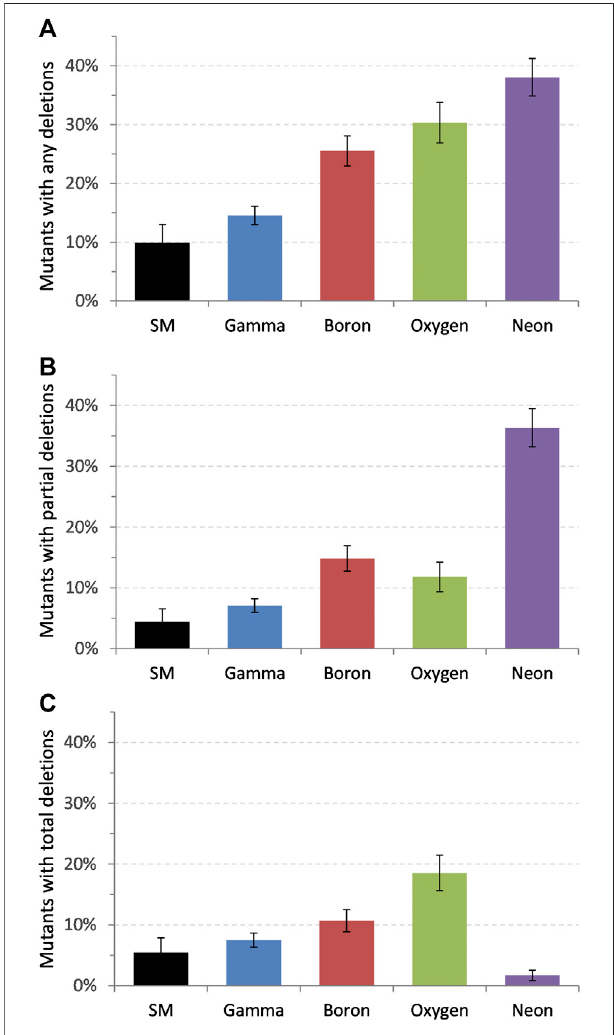
FIGURE 3 | Distribution of deletions in HPRT gene for all samples (averageofallthedosesandtimepointsassayed). (A) Alldeletionsscored, (B) partialdeletions,and (C) totaldeletions;SM,spontaneousmutants.Errorbars represent standard error of the